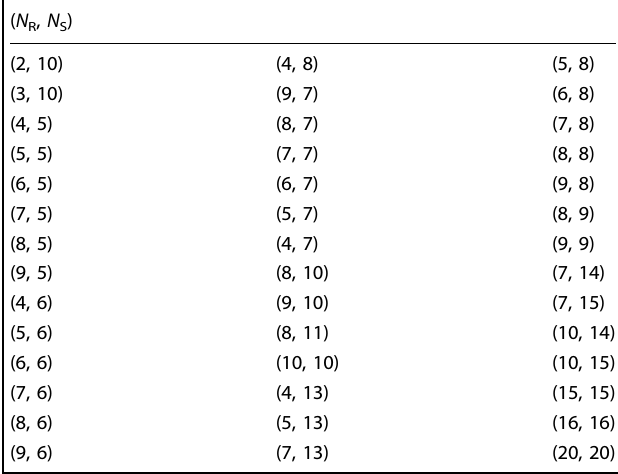
Table 4. Pairs ( N R , N S ), consisting of the number N R of satellite rings and the number N S of satellites per ring, used in all of the